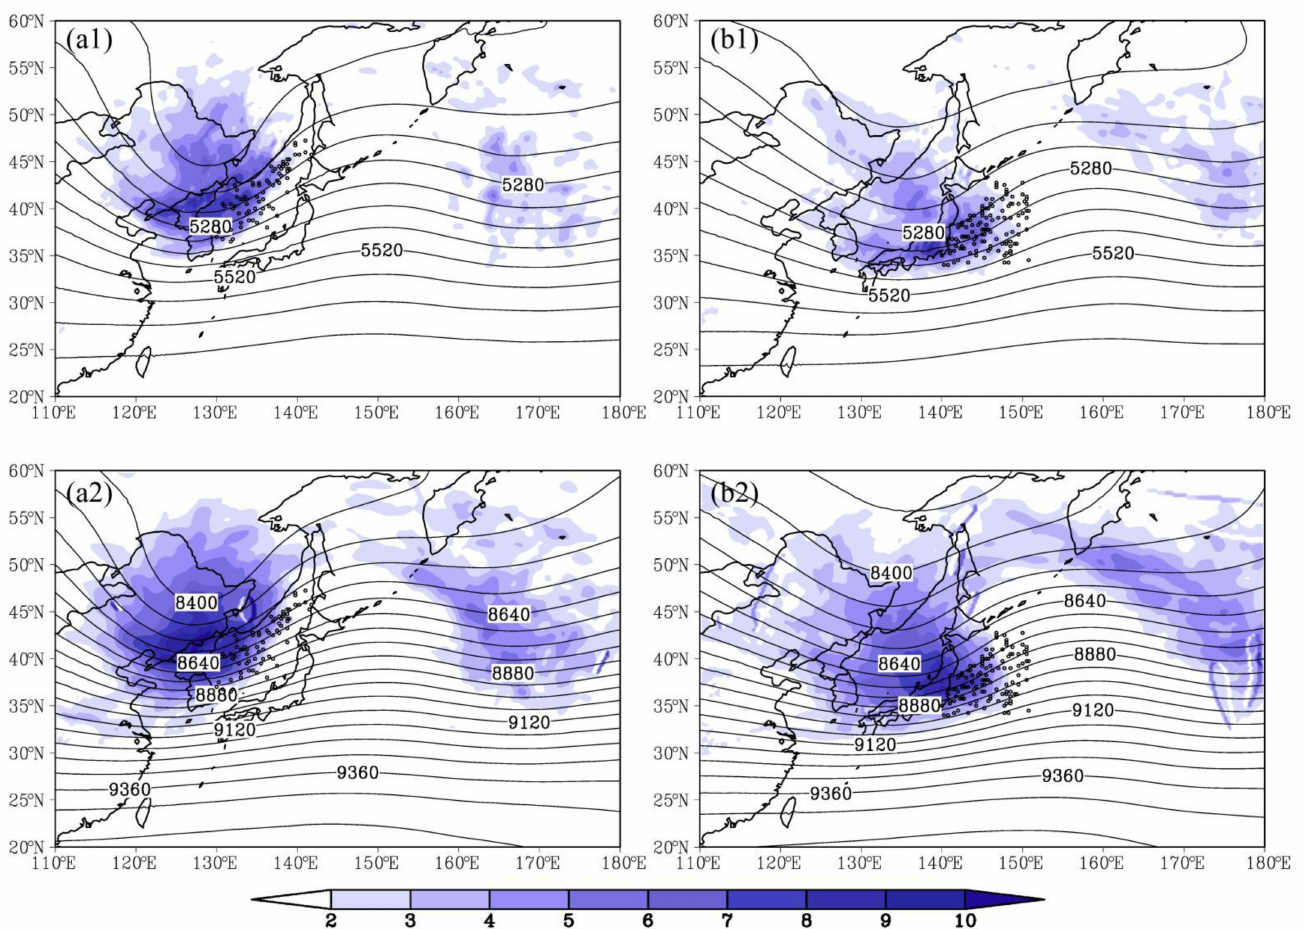
Figure 11. Composite fields of geopotential height (solid line, 40 pgm intervals) and relative vorticity (shaded, 1 × 10 − 5 s − 2 intervals) for ECs at the maximum-deepening-rate moment over ( a1 , a2 ) the Japan Sea and ( b1 , b2 ) Kuroshio/Kuroshio Extension at ( a1 , b1 ) 500 hPa and ( a2 , b2 ) 300 hPa. ” ◦ ” is the EC center at the maximum-deepening-rate